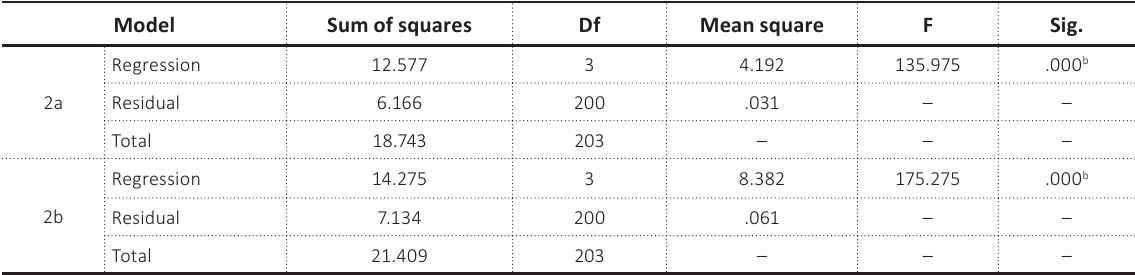
Table 3. Model fitness (ANOVA a )